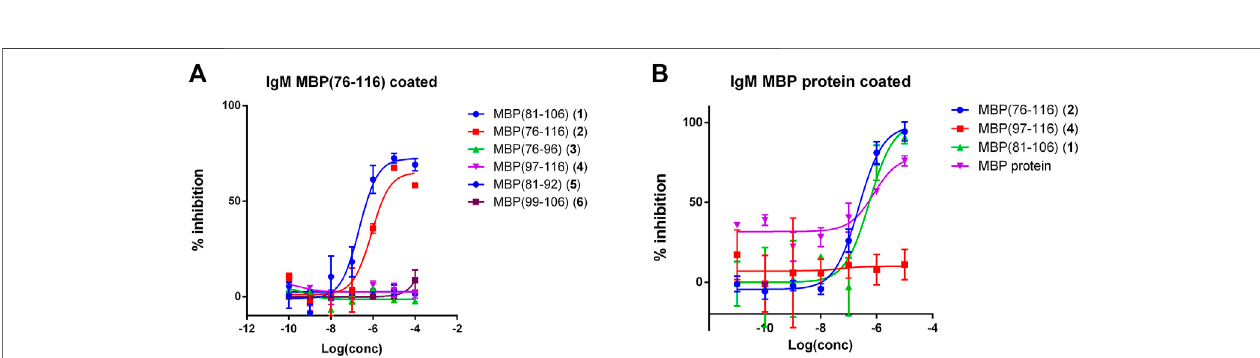
FIGURE 2 | Competitive ELISA obtained coating the peptide antigen MBP (76 – 116) (2) (A) or the MBP protein (B) . Inhibition curve of IgMs using peptides and protein as inhibitors at different concentrations. Results show the inhibition activity % (ordinate axis) of the reference MS serum for IgMs vs. antigen concentrations on a logarithmic scale (abscissas axis). Antibody titer values were calculated as (mean Abs of serum triplicate) — (mean Abs of blank triplicate) representing graphically the calculated mean values ± the standard